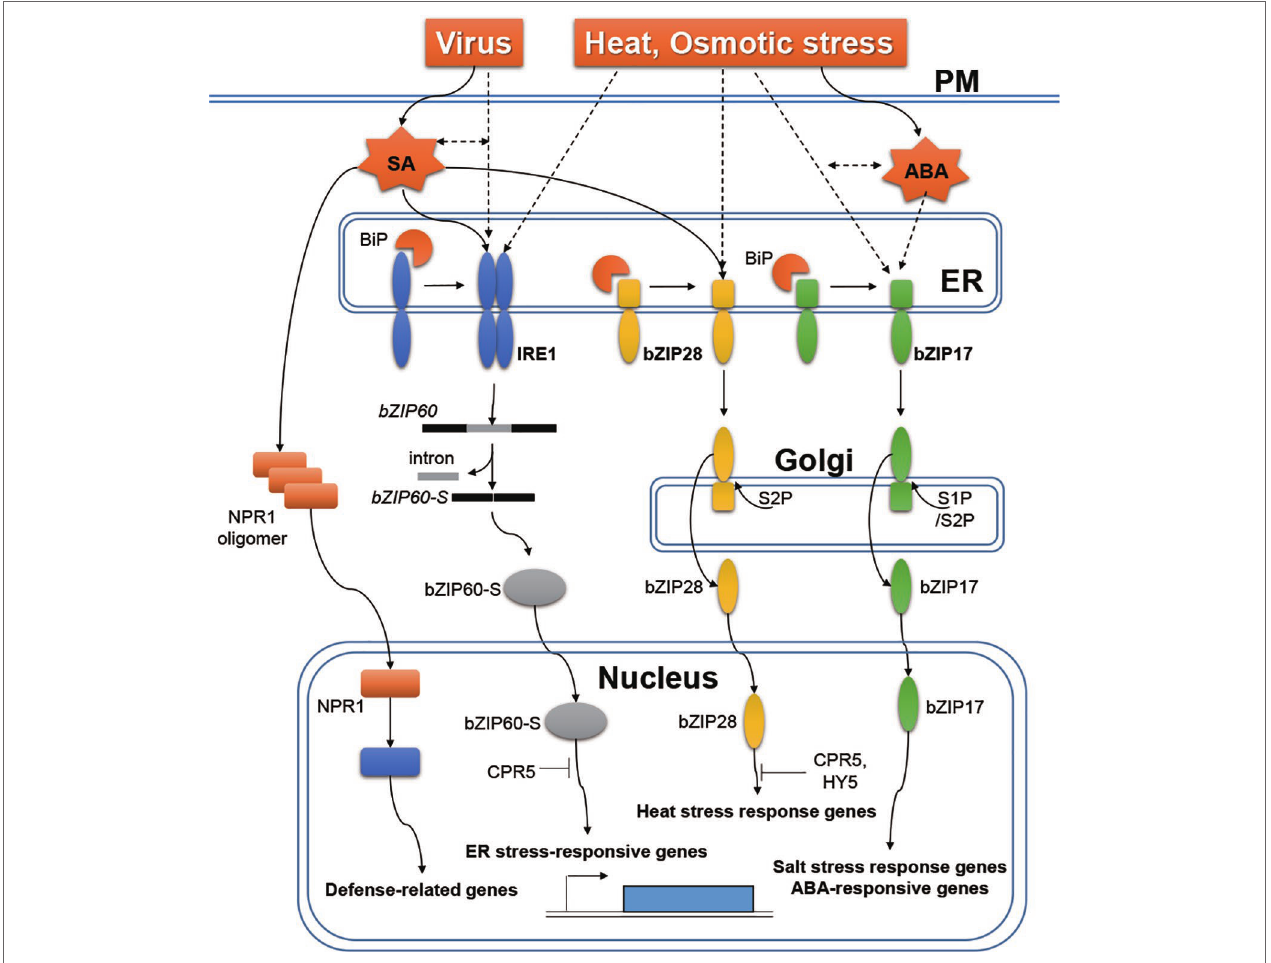
FIGURE 1 | ER stress responses to RNA viruses, heat and osmotic stress, and stress-related hormones in plants. Under biotic/abiotic conditions, BiP dissociates from IRE1 to bind unfolded proteins that accumulate in the ER. Activated IRE1 splices bZIP60 mRNA (bZIP60), resulting in a frame shift that generates a bZIP60 variant (bZIP60-S) targeted to the nucleus. When BiP is sequestered away, bZIP17/28 transcription factors are released from the ER to the Golgi apparatus, where they are cleaved. The cytosol-facing regions of bZIP17/28 are transported from the Golgi apparatus to the nucleus. After translocation, bZIP transcription factors upregulate the expression of stress response genes. Expression of bZIP60 is increased by viral infection. SA induces IRE1-mediated splicing of bZIP60 mRNA and proteolytic processing of bZIP28. SA regulates the expression of stress response genes via an NPR1-depenedent pathway. ABA promotes proteolytic processing of bZIP17. Dashed arrows indicate yet-uncharacterized molecular